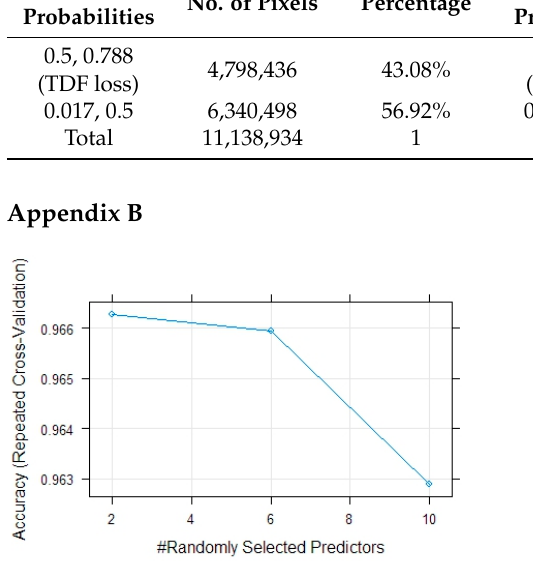
Figure A1. Cross-validation for the classification of Sentinel-2 imagery in 2022 with tested mtry = 2, 6, and 10. Mtry = 2 was selected for its highest accuracy.